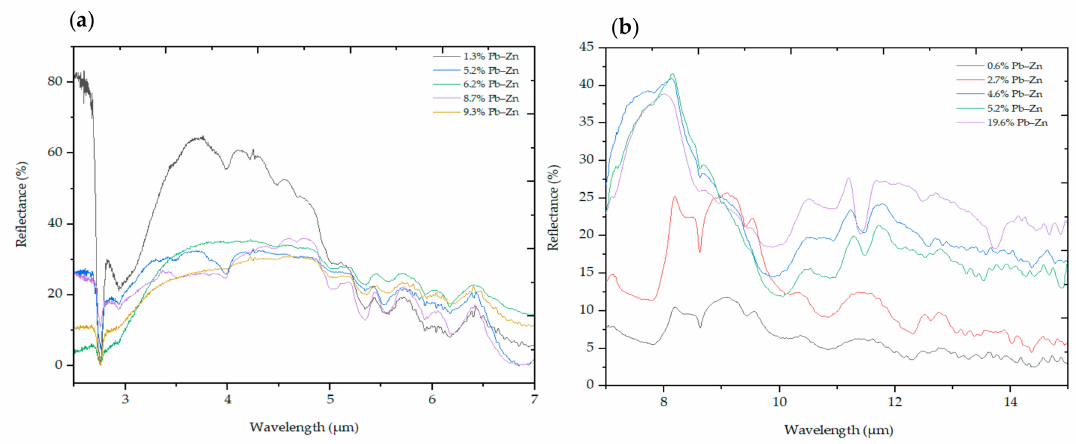
Figure 5. The spectra of some of the samples showing spectral variation based on the combined Pb-Zn concentration in the ( a ) MWIR and ( b ) LWIR regions of the